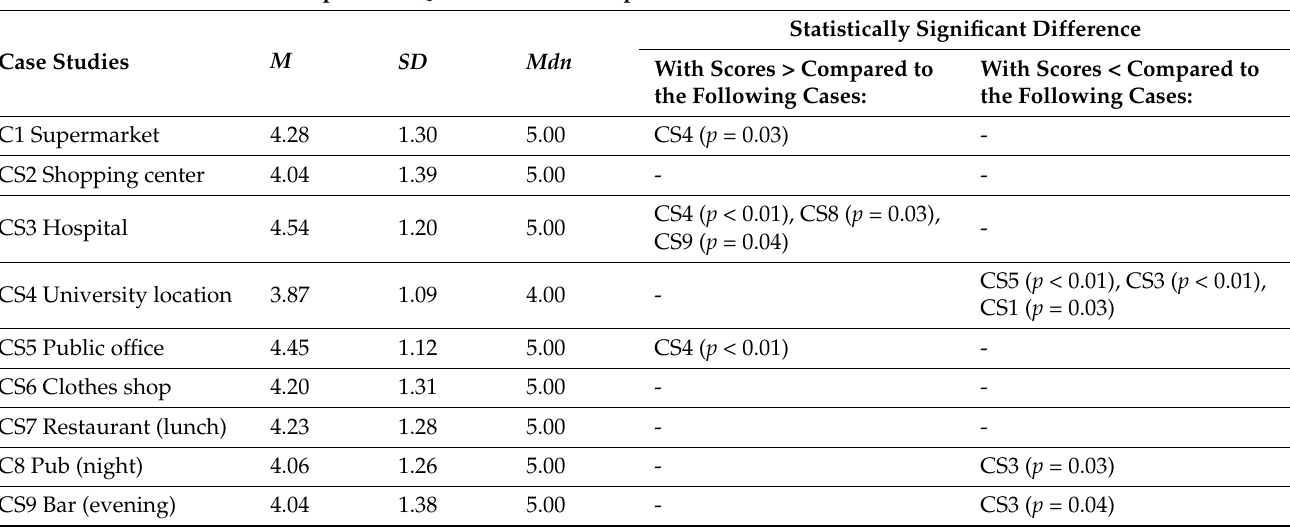
Table A20. Table shows the statistically significant differences ( p (BH)) that emerged from the comparison of item 18 in the different case studies (CS1–CS9). In the table is also reported the mean ( M ), the standard deviation ( SD ) and the median ( Mdn ). Own processing.